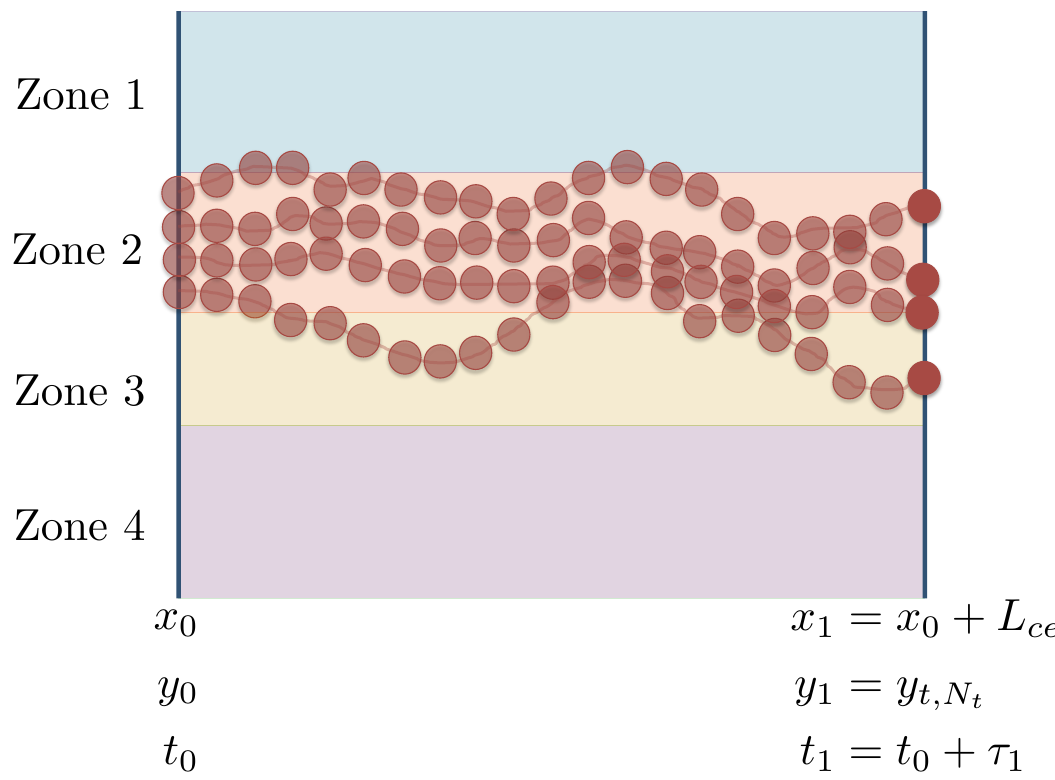
Figure 11. Illustration of the parameterization step for downscaling Method 3. For simplicity, the schematic only shows 4 zones, but in our simulations we separate the domain into N z = 20 equiprobable zones based on the initial y positions, y 0 . As is depicted here, we measure the particle y positions at N t = 20 equally spaced locations in x across the first cell in order to capture the trajectory of each particle. We illustrate this with four sample trajectories for particles in Zone 2. The particle trajectories defined by y t ,1 , y t ,2 , ..., y t , N may have y positions outside of their defined zone, but this does not t change the set of y values associated with each zone Y j to which they contribute. The set Y j contains all y positions y 0 , y t ,1 , y t ,2 , ..., y t , N = y 1 for every particle that had y 0 in that t